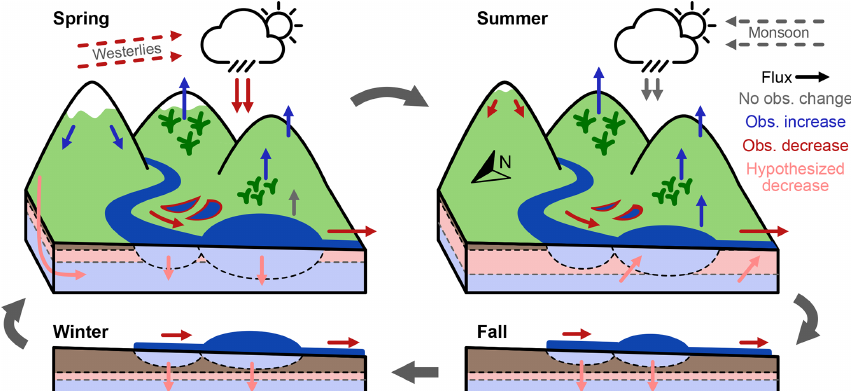
Figure 10. Conceptual diagram of seasonal water fluxes and direction of change. The subsurface cross section represents the thick layer (up to 1km) of sedimentary deposits in the valley (see Sect. 2). Black, red, and blue arrows indicate observed fluxes combined with the observed sign of change. Pink arrows indicate groundwater fluxes that have been inferred and hypothesized to decrease over the study period. Both natural vegetation on hillslopes and agricultural crops in the valley exhibit increased evapotranspiration (Fig. 6). See the text for